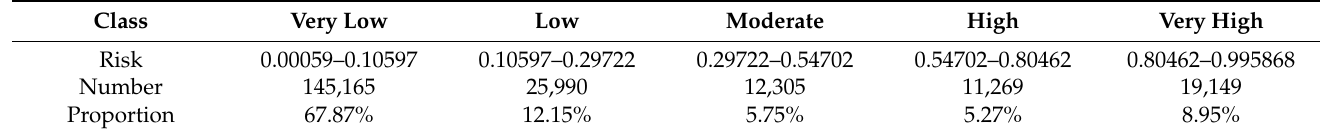
Figure 6. Result validation: ( a ) Inundation risk of the study area from the model; ( b ) overlay comparison of modeled high-risk area against actual inundation extent. Table 2. Risk